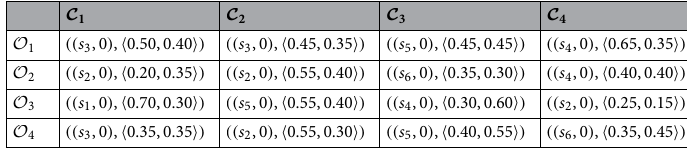
Table 6. q-ROPFL data provided by D 2 .